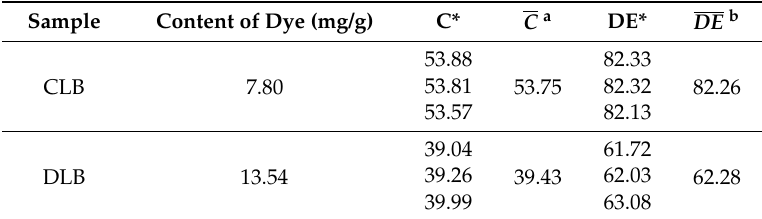
Table 1. The dye contents of CLB and DLB and their color coordinates.